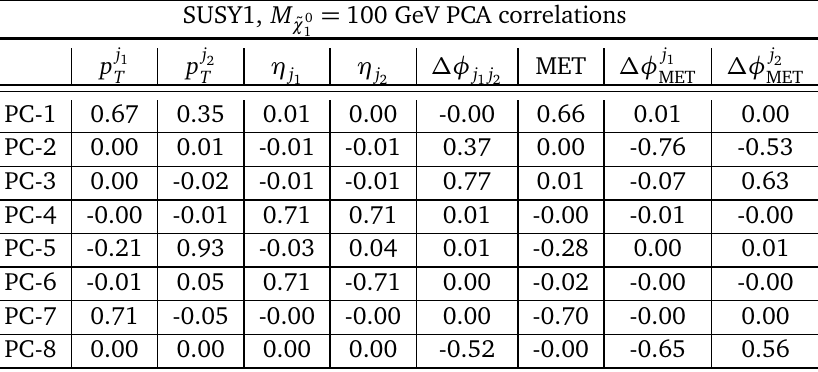
Table B3: PCA original features to principal component correlations for the SUSY1 case (rounded to 2 d.p.).